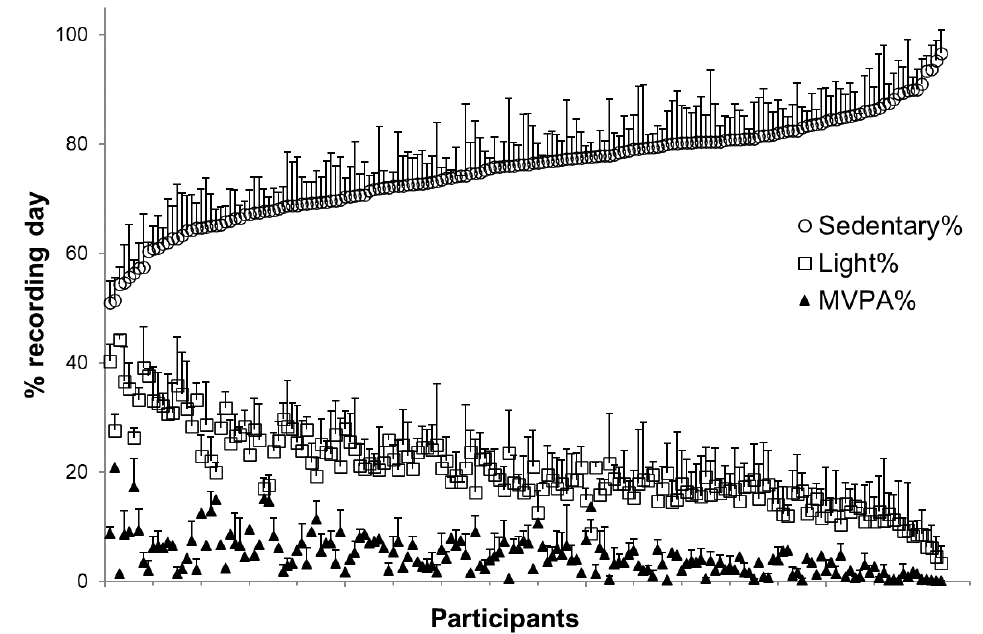
Figure 1. Individual time spend of sedentary, light physical activity (PA), and moderate-to-vigorous physical activity (MVPA). Data are organized according to the amount of measured sedentary time. Standard deviations denote day-to-day variation during the measurement week for each intensity activity. The x axis is labelled according to each participant.